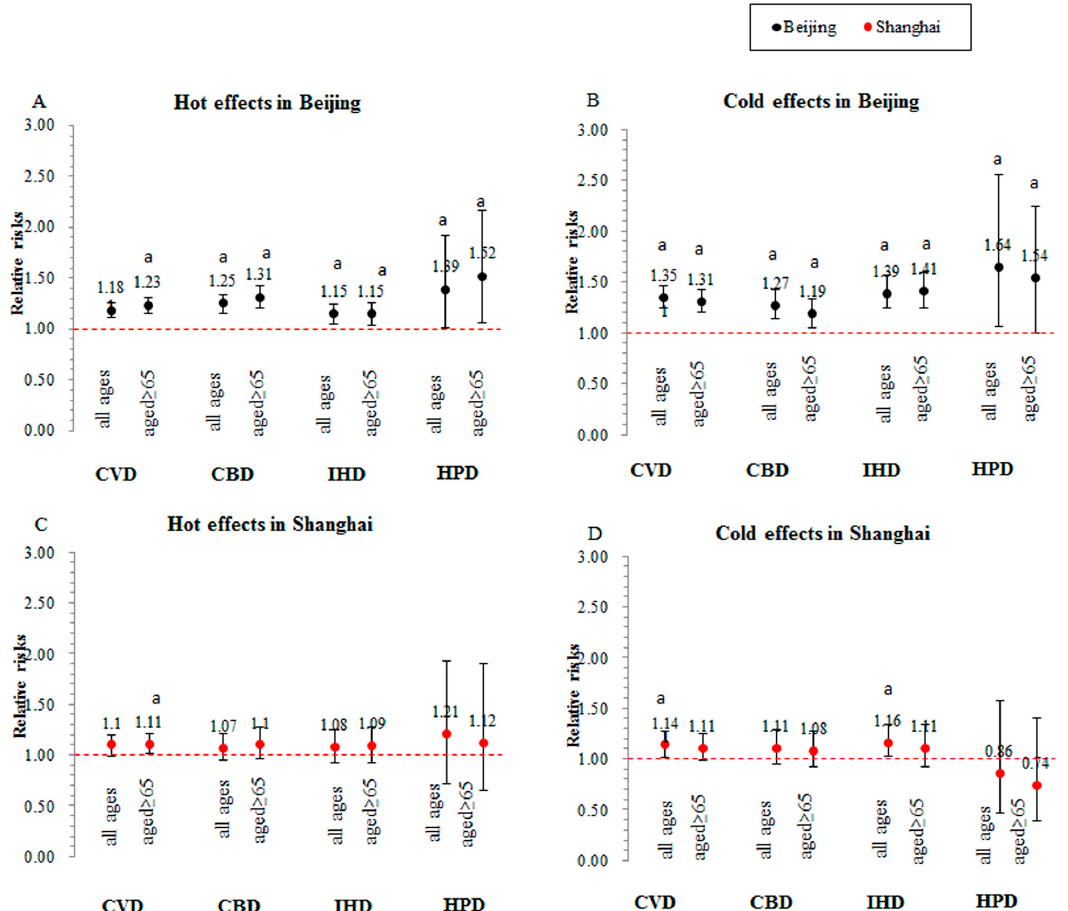
Figure 3. The cumulative hot effects at lag 0–14 days and cold effects at lag 0–27 days on cause-specific cardiovascular mortality among all ages and those aged ≥ 65 years in Beijing and Shanghai, China; a p < 0.05.